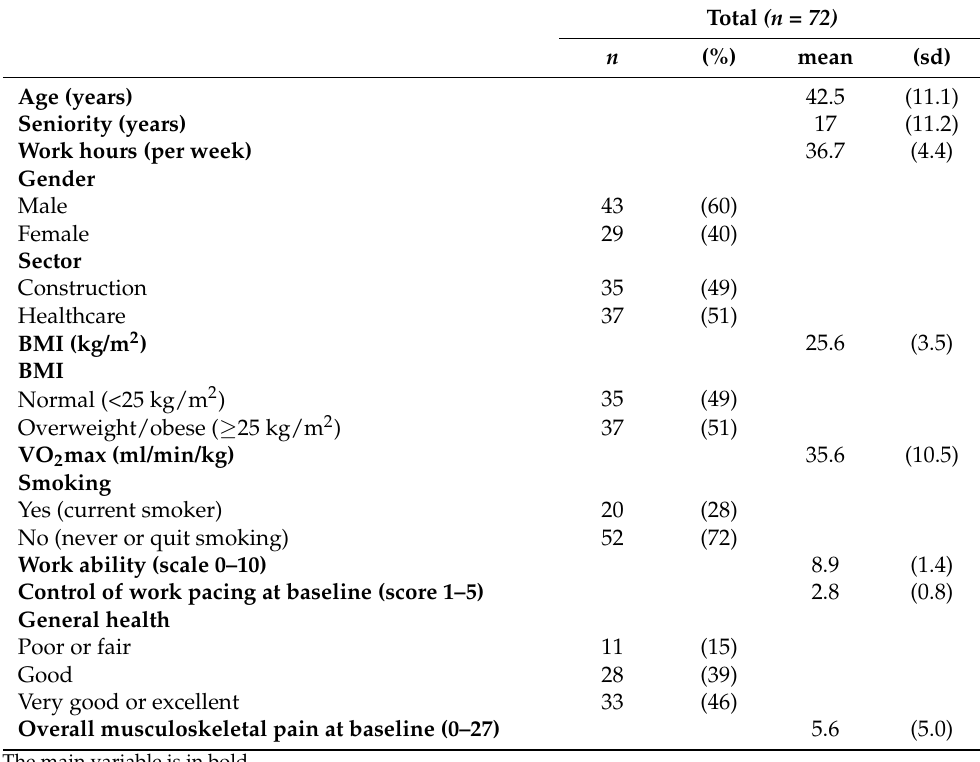
Table 1. Participant characteristics at